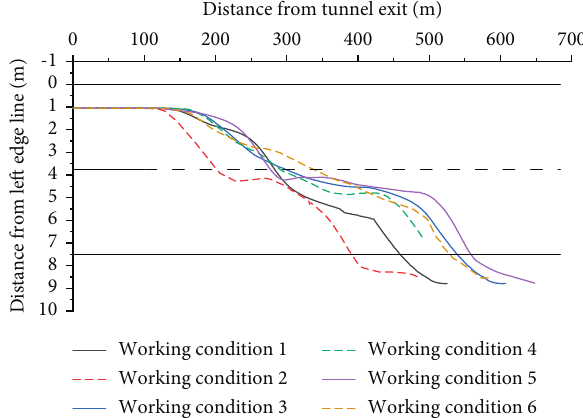
Figure 4: Vehicle trajectories under different working conditions of the first service level.